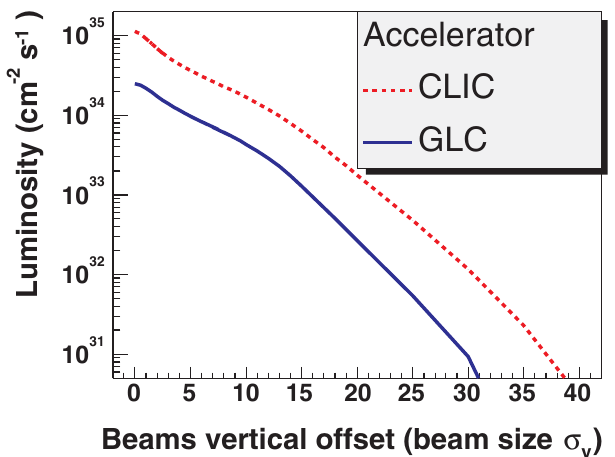
FIG. 1. (Color) Total luminosity delivered as a function of the vertical offset of the beams at the interaction point. The hori- , is the vertical size of the beam (a few nano- zontal unit, (cid:1) y meters). The parameters used for this simulation are those of the head-on collisions have